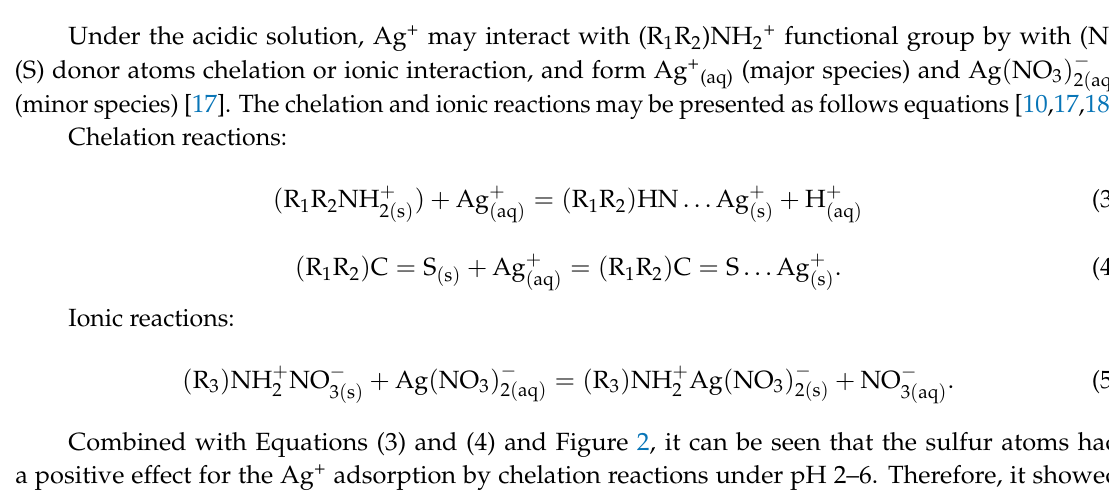
Figure 2. Effect of initial acidity on the removal rate of Ag + .